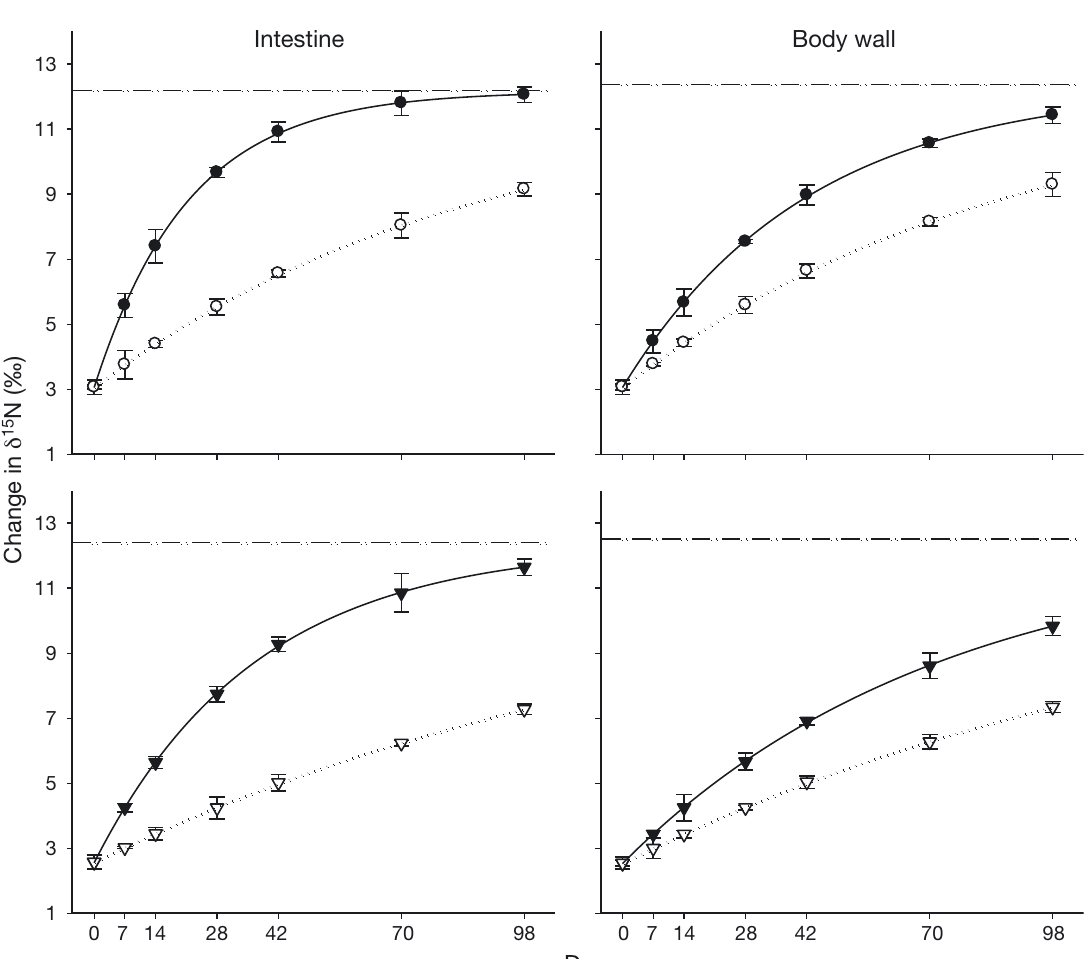
Fig. 3. Changes in the δ 15 N values estimated with time-based turnover model for intestine (left column) and body wall (right column) of green (circles) and white sea cucumber (triangles) fed a single natural diet of Sargassum thunbergii . Solid lines/filled symbols: δ 15 N values with the contribution of growth and metabolism; dotted lines/open symbols: δ 15 N values with the contribution of growth alone (metabolic turnover constant, m = 0). Horizontal dash-dotted line: expected δ 15 N values when tissues are completely equilibrated to S.